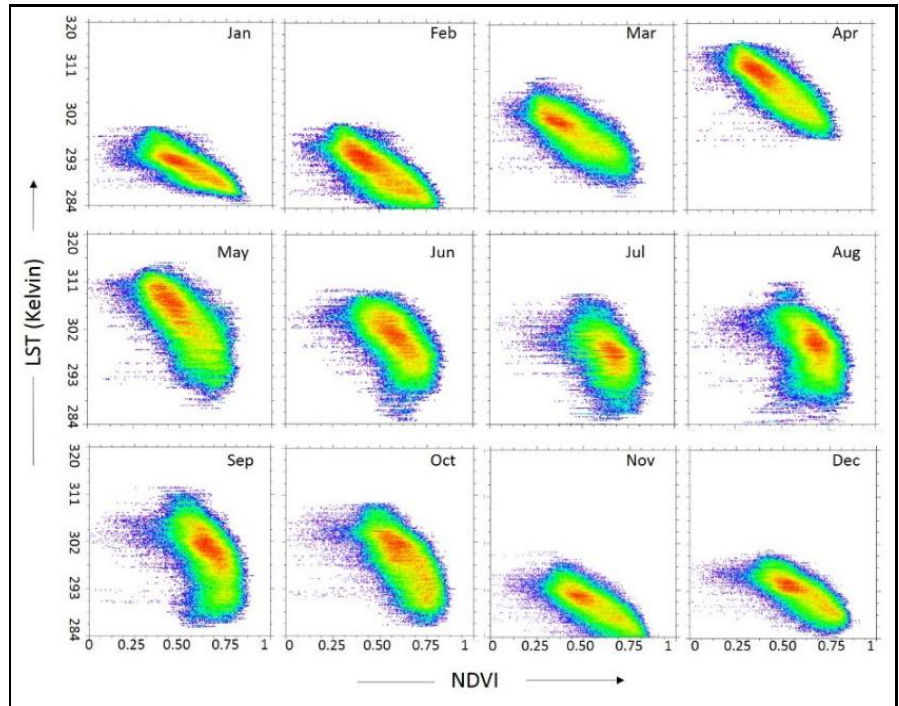
Figure S2. Density scatterplots between NDVI (x-axis) and LST (y-axis), indicating a dominant negative correlation across the